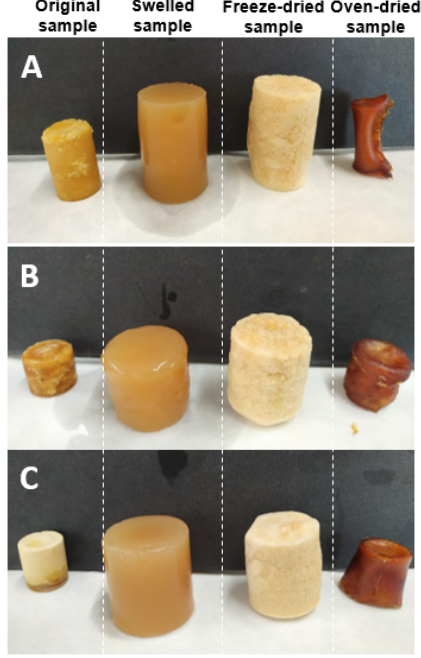
Figure 4. Appearance of swollen, freeze-dried, and heat-dried (in a natural convection oven) compression-molded porcine plasma protein (PPP)-based materials with different PPP/Gly ratios: 50/50 ( A ), 75/25 ( B ), and 100/0 ( C ).